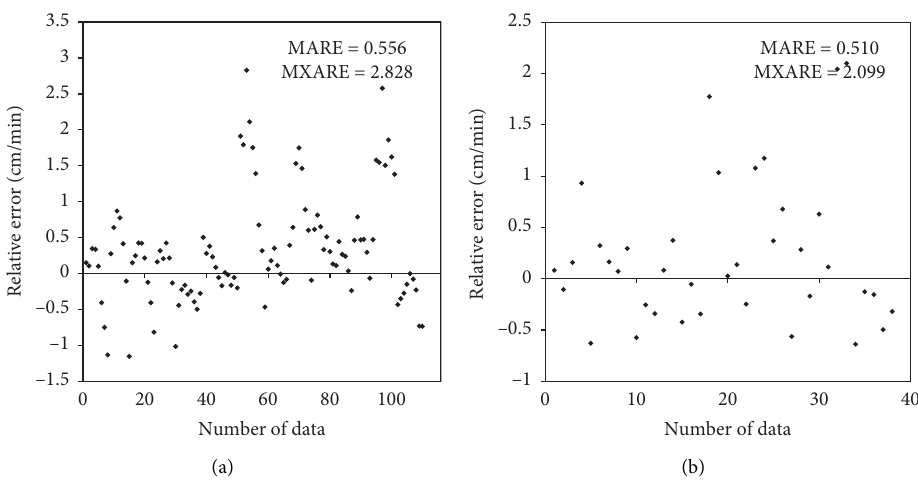
Figure 6: Relative error plots for the MLR model for the training and testing data.